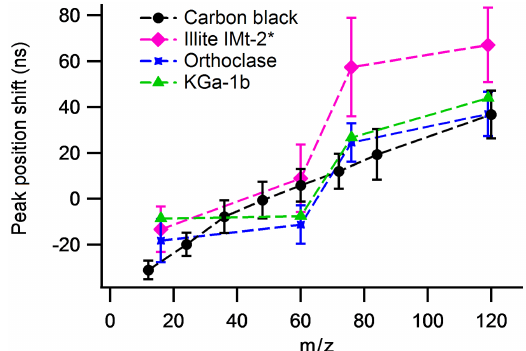
Figure 6. Shift in ion arrival times ( (cid:49)T (i) ) with respect to a nominal negative ion calibration with borosilicate glass. The mean and two SDs of the mean were calculated from 800 spectra per sample type.